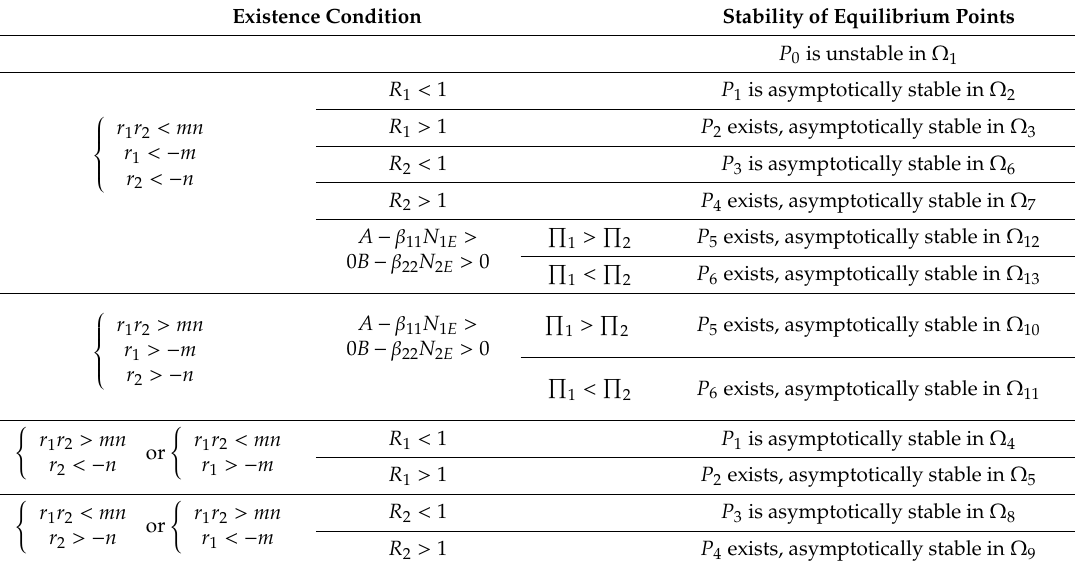
Table 3. Stability of equilibrium point of the four-dimensional system.